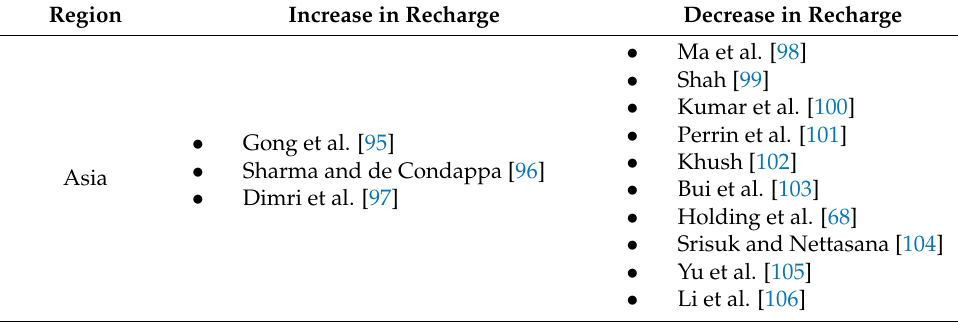
Table 4. Scientific production identified for